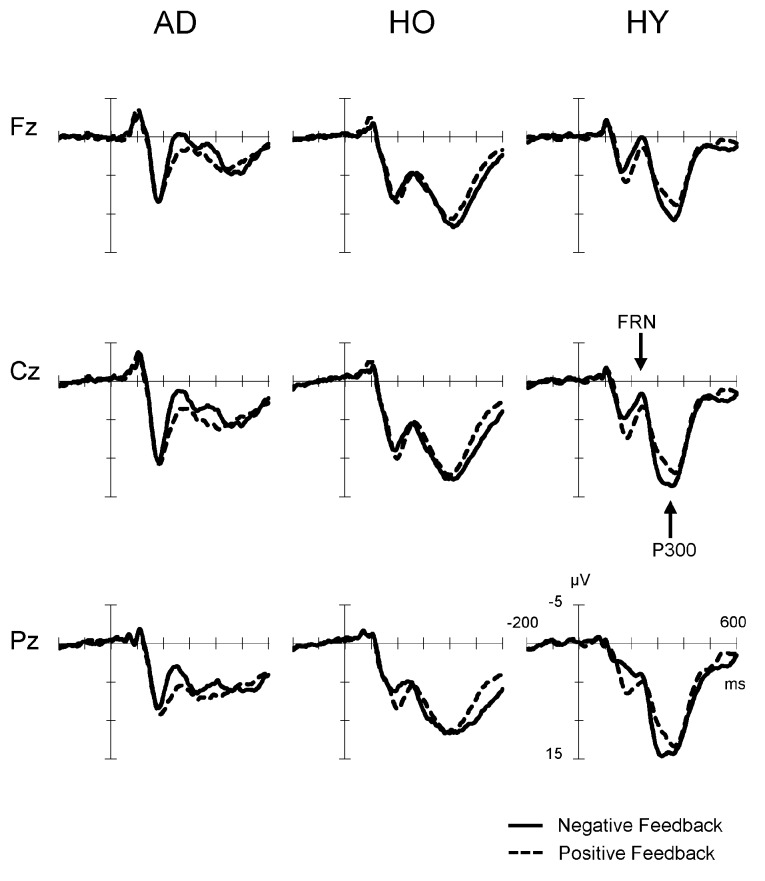
Grand-average event-related potential (ERP) waveforms time-locked to feedback onset according to conditions (negative feedback or positive feedback) at Fz, Cz and Pz in each group. Waveforms for negative feedback (solid line) and positive feedback (dashed line) are inserted as overlays. AD, Alzheimer’s disease; HO, healthy old; HY, healthy young.